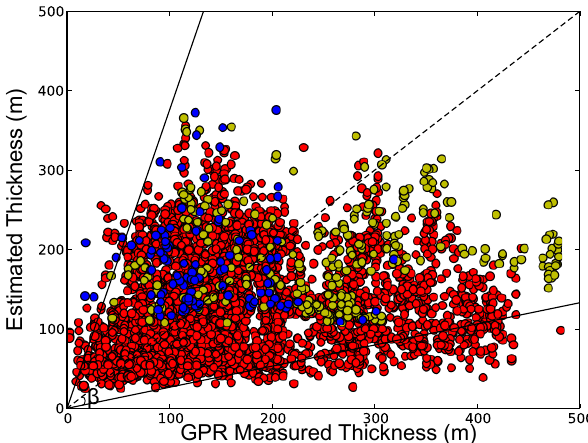
Figure 5. Measured vs. estimated ice thickness according to Eq. (5). The dashed line indicates the 1-to-1 line. Continuous lines show the 95% error boundary corresponding to β = 30 ◦ . Beta angle is used for error projections. Red, green and blue dots are used to distin- guish points from the glacier regions with slow, medium and fast flow speeds,